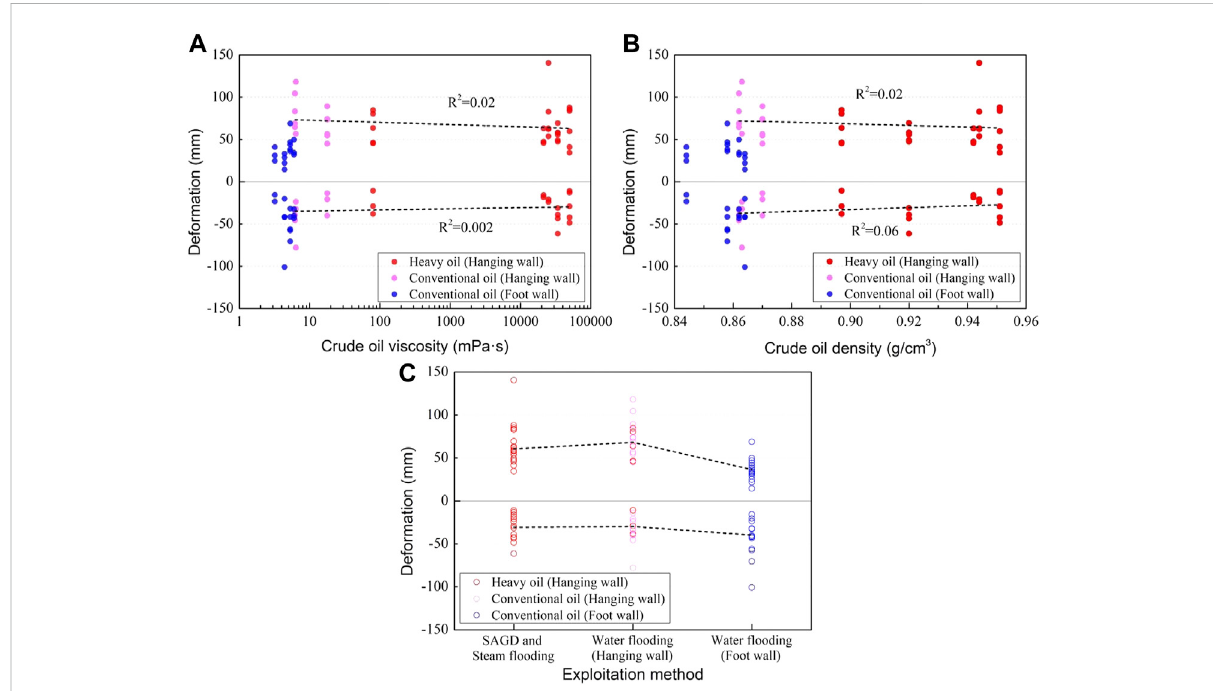
FIGURE 6 Relationships between crude oil properties as well as exploitation methods and surface deformation. The red points represent the heavy oil, distributed only in the hanging wall of the thrust fault belt. The pink points and the blue points represent the conventional oil, distributed in both hanging wall and foot